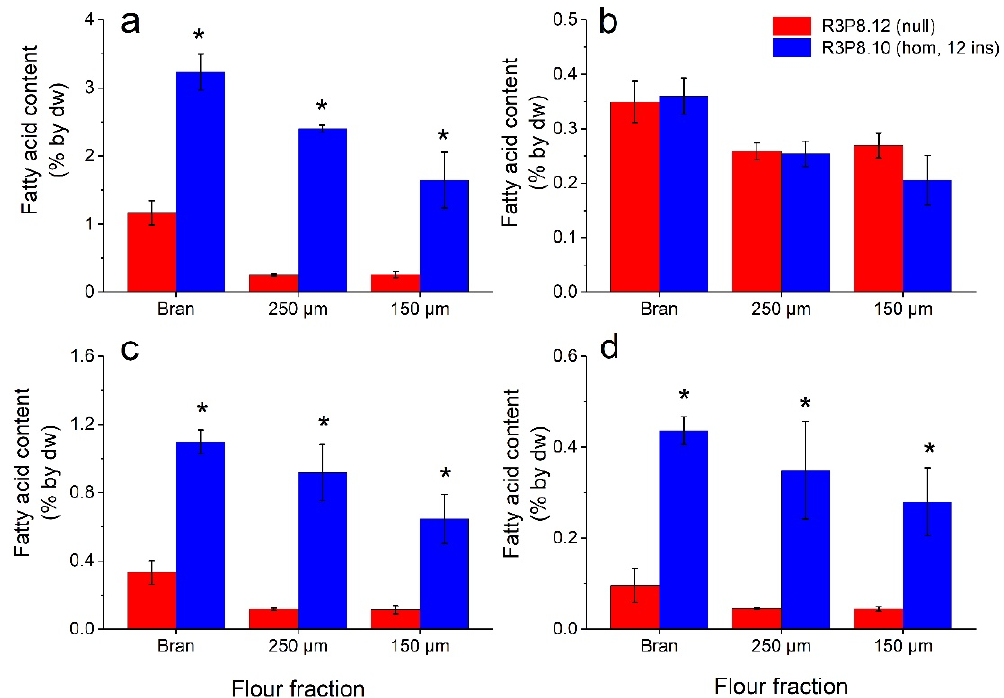
Figure 11. Lipid content (based on amounts of major fatty acids 16:0 (palmitic acid), 18:0 (stearic acid), 18:1 (oleic acid), 18:2 (linoleic acid), 18:3 (linolenic acid) and 20:1 (eicosenoic acid)) in three different flour fractions (bran, 250 µ m, and 150 µ m mesh) from mature wheat grains from field grown AsWRI1 -wheat (line R3P8.12, null (control); line R3P8.10, homozygous with 12 gene inserts). Levels of fatty acids are given as a percentage of tissue dry weight (dw) from ( a ) triacylglycerol (TAG), ( b ) polar lipids (PL), ( c ) free fatty acids (FFA), and ( d ) other lipids. Results are mean values of three replicates (i.e., plots) ± standard deviation. Bars marked with asterisks are significantly different to control (null) according to Fisher’s pairwise comparisons ( p < 0.05).